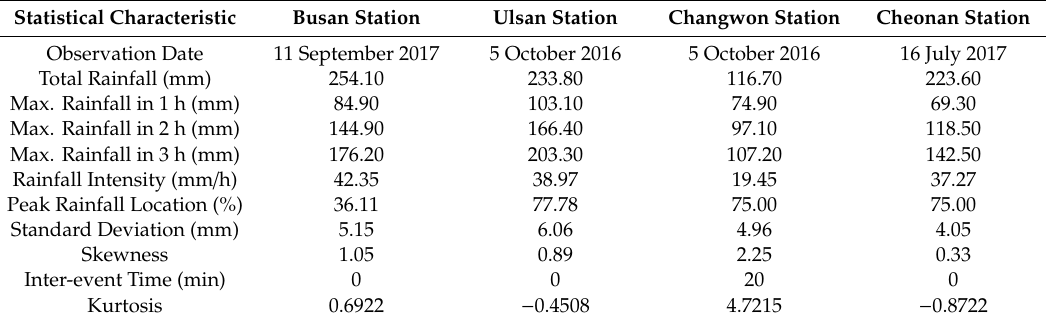
Table 3. Observed rainfall and statistical features (four observation stations in other